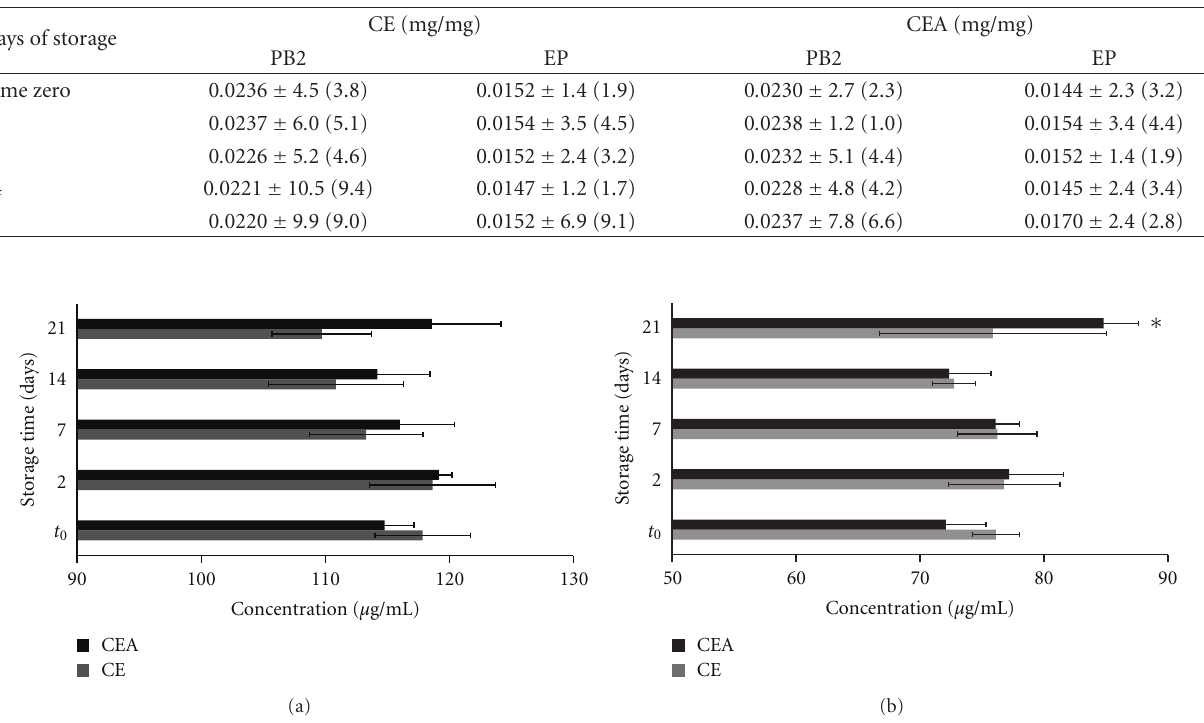
Figure 4: Influence of colloidal silicon dioxide on the dried-extract (CE and CEA) of Guazuma ulmifolia. (a) procyanidin B2 (PB2) and (b) epicatechin